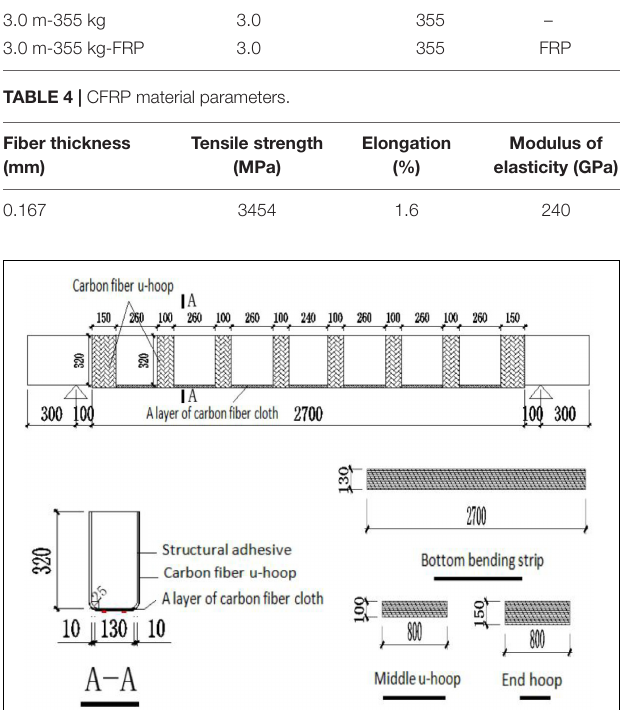
FIGURE 4 | CFRP reinforcement method (units: